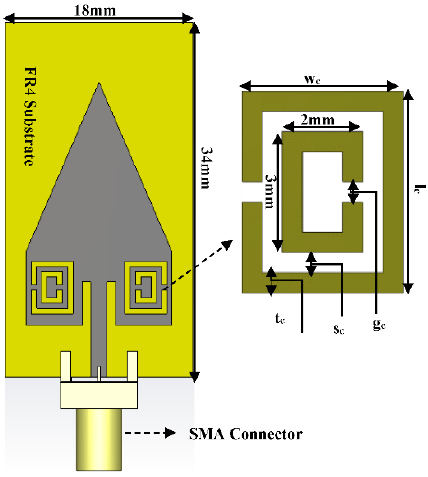
Figure 3. Layout of proposed antenna design.